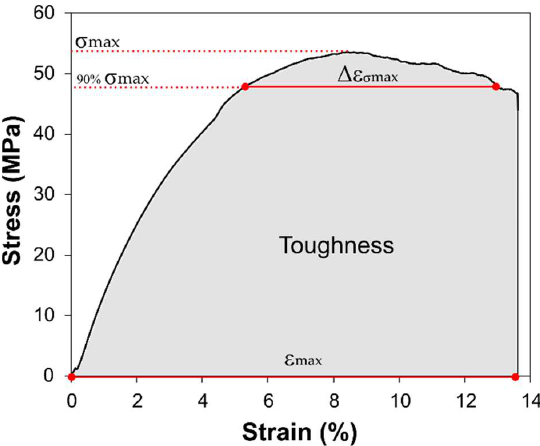
Figure 5. Main stress–strain parameters for toughness evaluation.